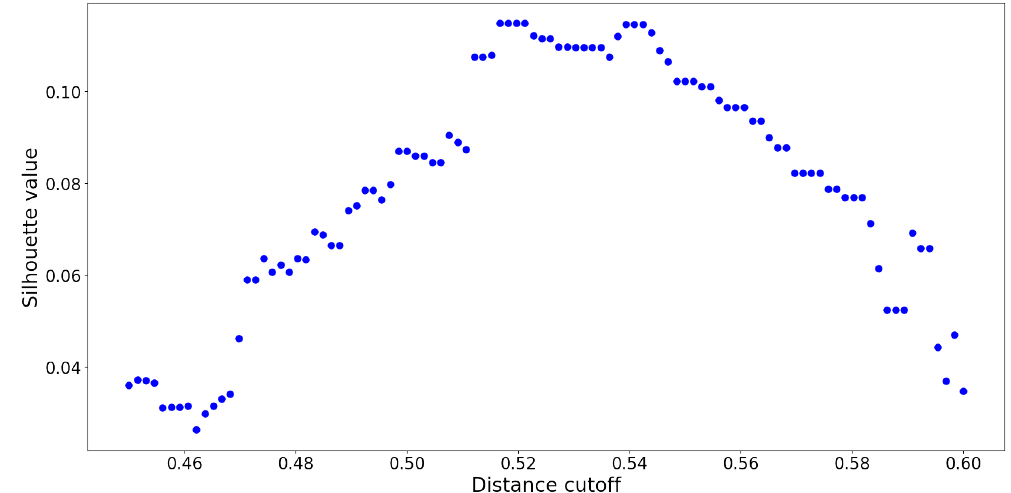
Figure 10. Silhouette values as a function of distance cut-off in UPGMA clustering. The optimal cutoff value is the one corresponding to the maximum silhouette